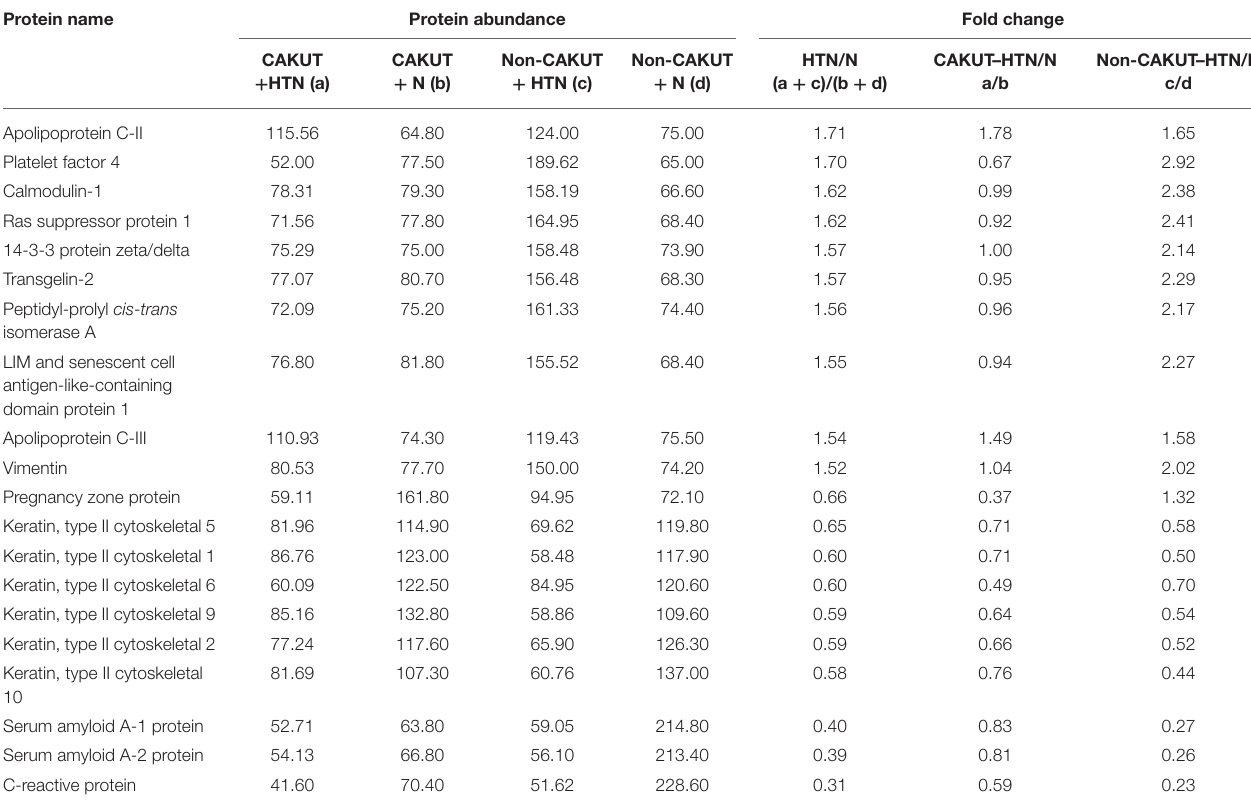
TABLE 1 | Comparison of the abundance of proteins differentially expressed in children with CKD and blood pressure abnormalities. Protein